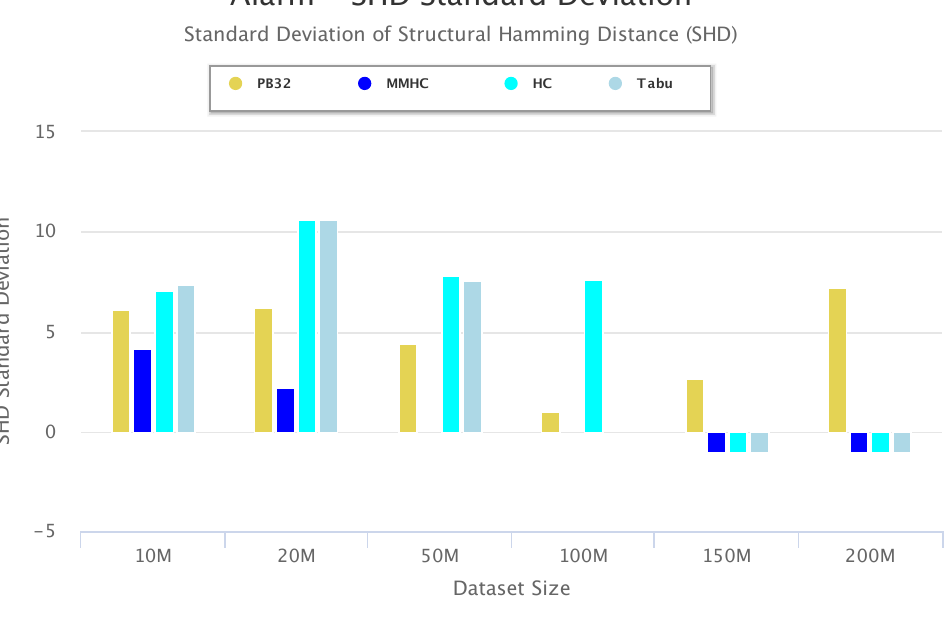
Figure 16. Alarm Set Standard Deviation